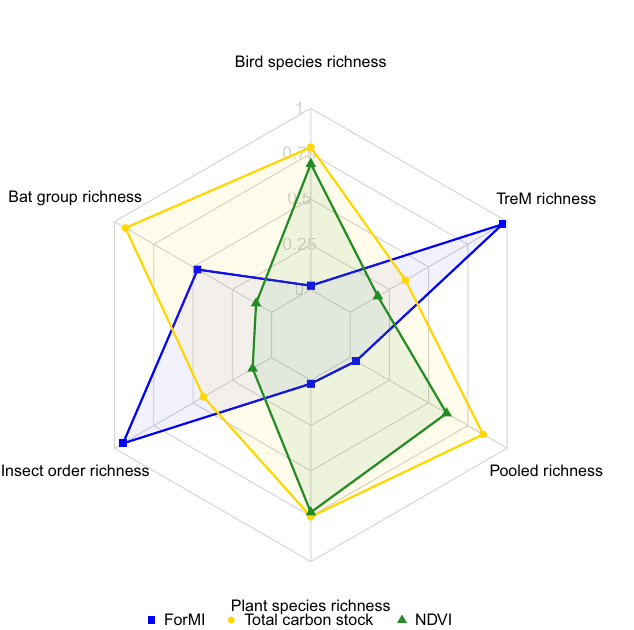
Figure 1. Scaled relative importance of forest management intensity (ForMI), total tree biomass carbon stock and NDVI on the richness of four taxonomic groups, the pooled richness of those groups and richness of tree- related microhabitats. Relative importance ranges between 0 and 1. This graph was produced in R using the fmsb package 46